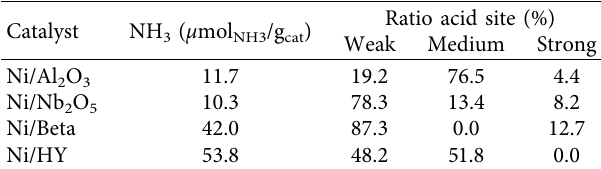
2 O 3 , Ni/Nb 2 O 5 , Ni/Beta, and Ni/HY catalysts. Table 3: Amount of NH 3